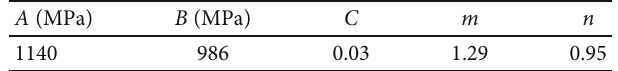
Figure 12: Finite element model of the blade and sphere. Table 2: Johnson-Cook material constants for